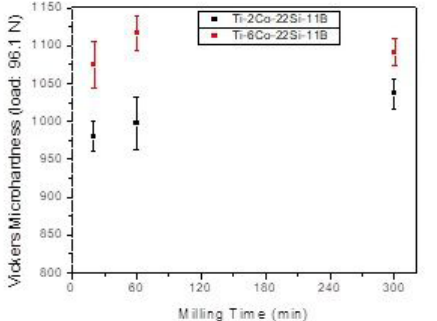
Figure 7. Vickers Hardness values of the SPSed (a-c) Ti-2Co-22Si- 11B and (d-f) Ti-6Co-22Si-11B alloys produced with powders milled at different times: (a,d) 20 min, (b,e) 60 min, and (c,f) 300